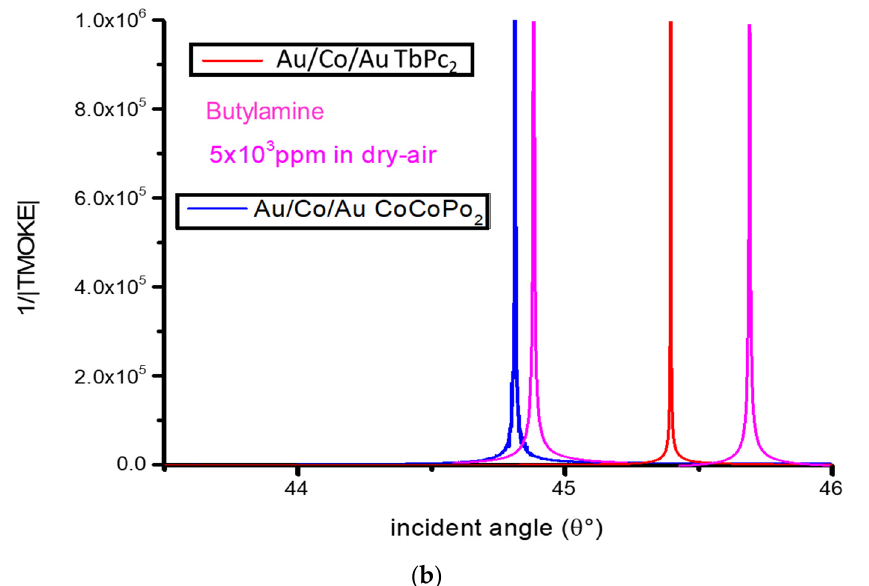
Figure 10 . ( a ) 1/|TMOKE| signal vs. incidence angle of the Au/Co/Au transducer alone compared with the same signals acquired in the presence of a single monolayer of CoCoPo 2 and TbPc 2 (OC 11 H 21 ) 8 macrocycles. The coloured circles represent the investigating laser size (<0.5 mm). ( b ) 1/|TMOKE| signals vs. incidence angle in Kretschmann configuration for CoCoPo 2 and TbPc 2 (OC 11 H 21 ) 8 monolayers interacting with butylamine vapours, respectively.